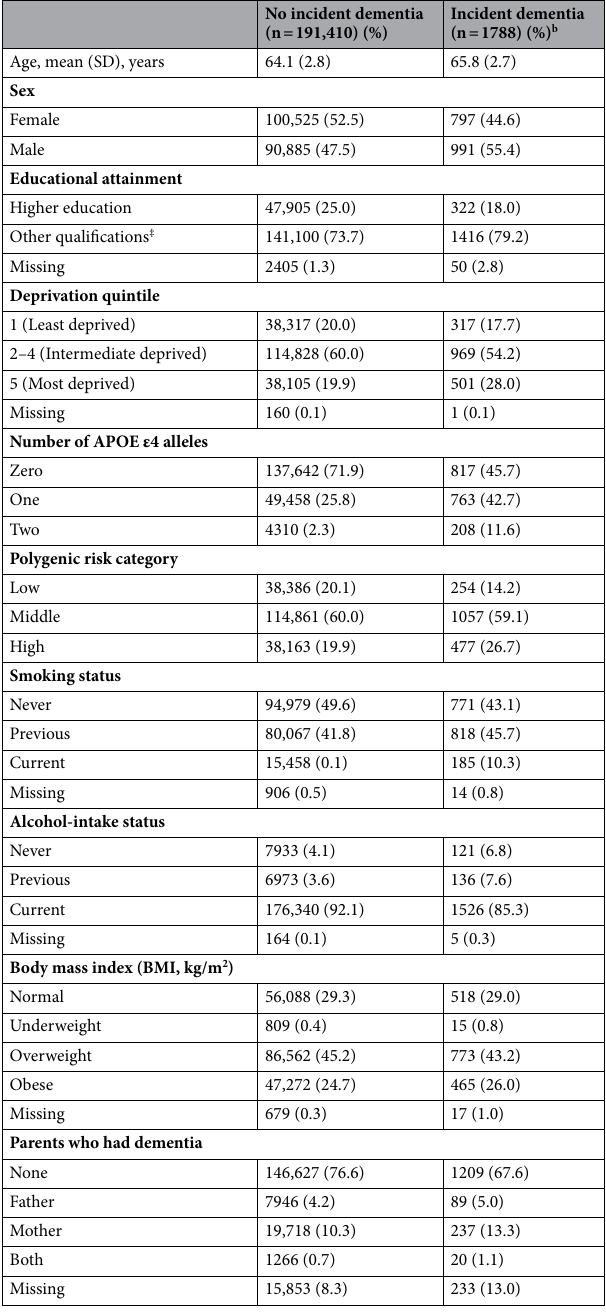
Table 1. Baseline characteristics of participants. a Other qualifications indicate without a college or university- level degree. b Percentages may not sum to 100 because of